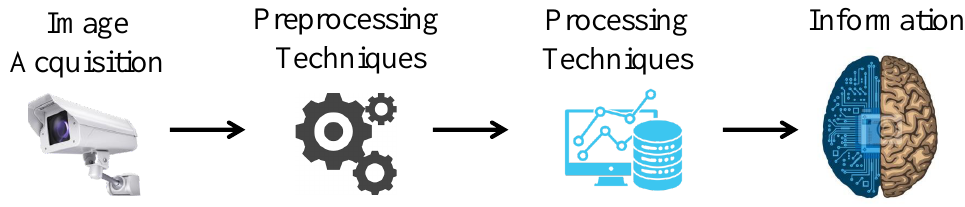
Figure 1. Components of an image processing